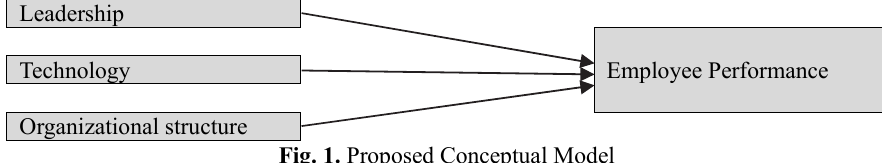
Fig. 1. Proposed Conceptual